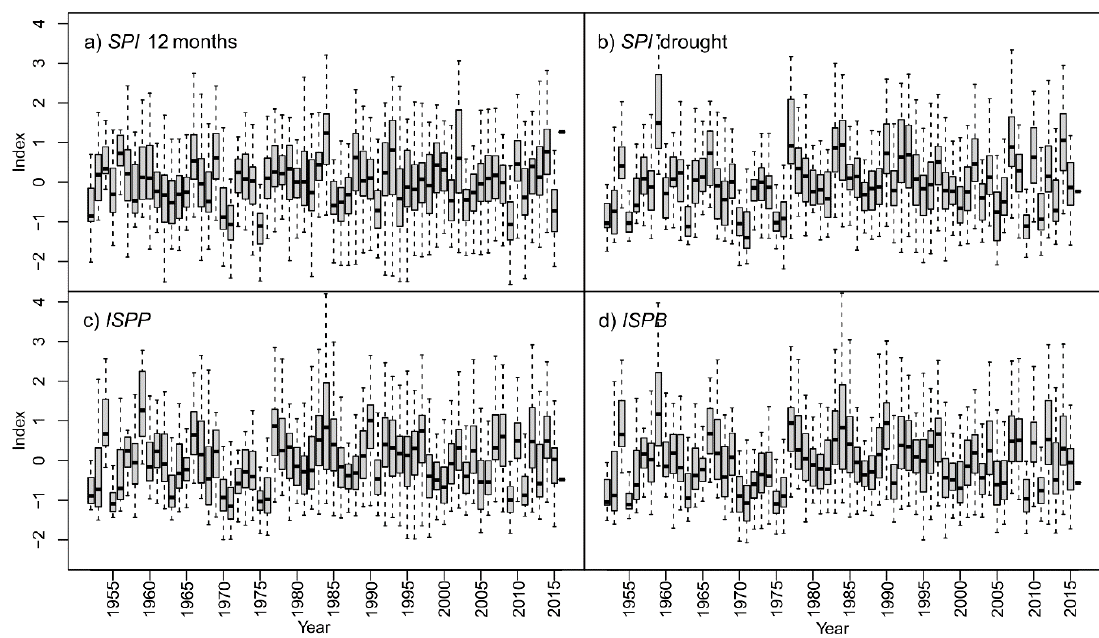
Figure 2. Time-series of Standard Precipitation Index 12 months ( a ), Standard precipitation Index for pre-summer drought period ( b ) pre-summer drought index—precipitation (ISPP) ( c ) and pre-summer drought index—water balance (ISPB) ( d ) for 52 stations in the Yucatan Peninsula.